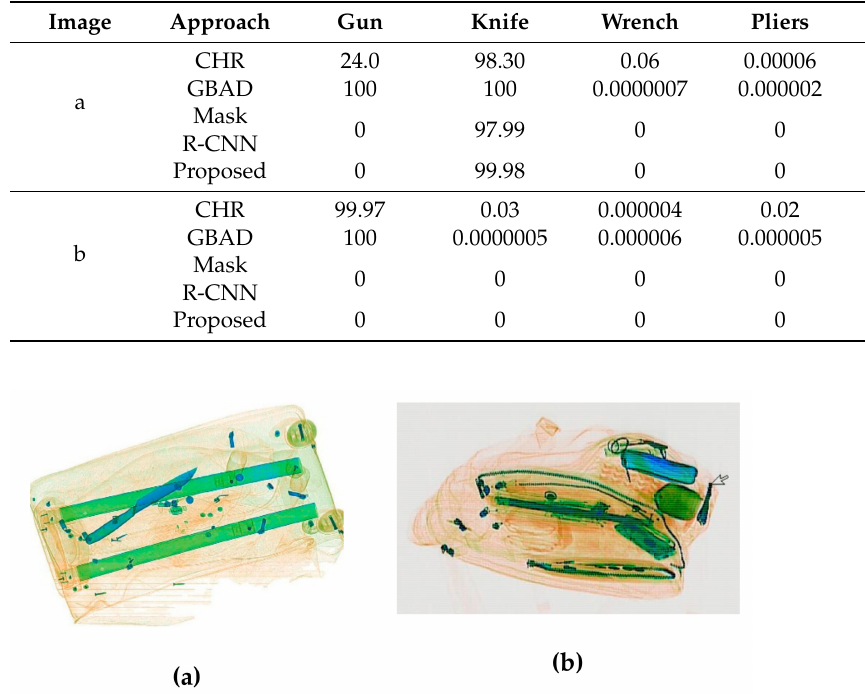
Figure 8. Randomly sampled images from the SIXray100 test set. The images were drawn from the pool of ( a ) positive and ( b ) negative